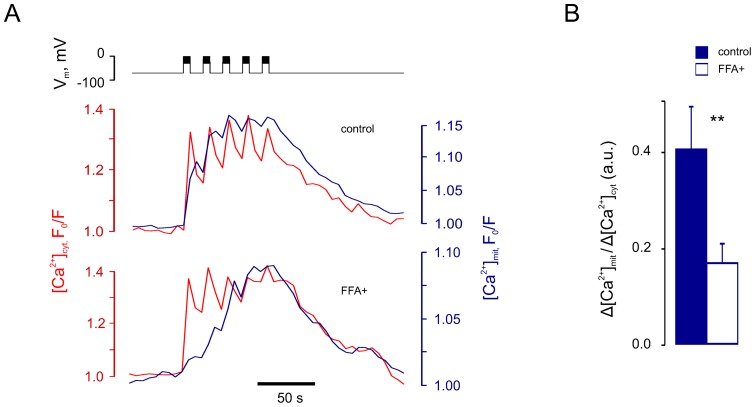
Chronic exposure to high-glucose and high-FFA medium impairs Ca2+ entry into mitochondria.β-Cells were pre-cultured in FFA-free medium containing 11 mM glucose (“control”) or medium containing 17 mM glucose and 0.5 mM palmitate (“FFA+”) for 48–72 h. A: The cells were voltage-clamped at −70 mV and five depolarising bursts were applied at 4 min−1, as indicated in Vm trace (above). [Ca2+]cyt and [Ca2+]mit were monitored with Fura-Red and 2mt8RP, respectively. B: Peak [Ca2+]mit induced by a single burst related to the respective peak [Ca2+]cyt (Δ[Ca2+]mit/Δ[Ca2+]cyt), measured in control (blue columns, n = 10) and FFA+ (white columns, n = 9) cells. *Differences are significant with p<0.05 (*) or p<0.01 (**).